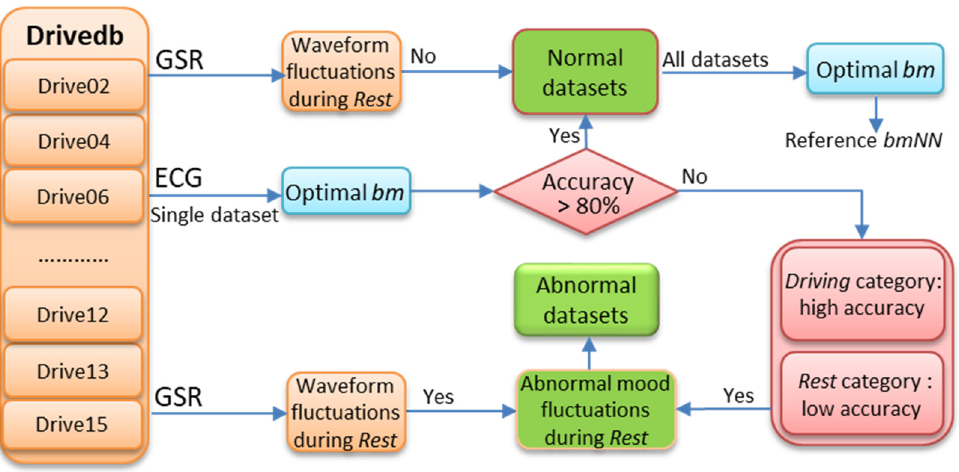
Figure 2. Block diagram of the recognition strategy for driving stress of the datasets in the drivedb database.